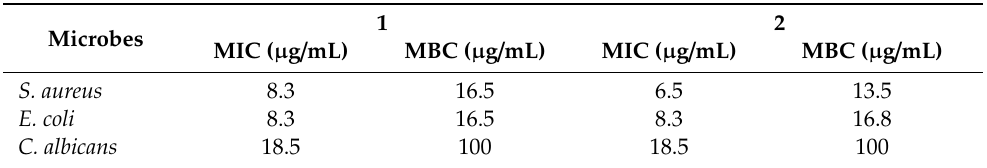
Table 9. The minimum inhibitory concentration (MIC) and minimum bactericidal concentration (MBC) of complexes 1 and 2